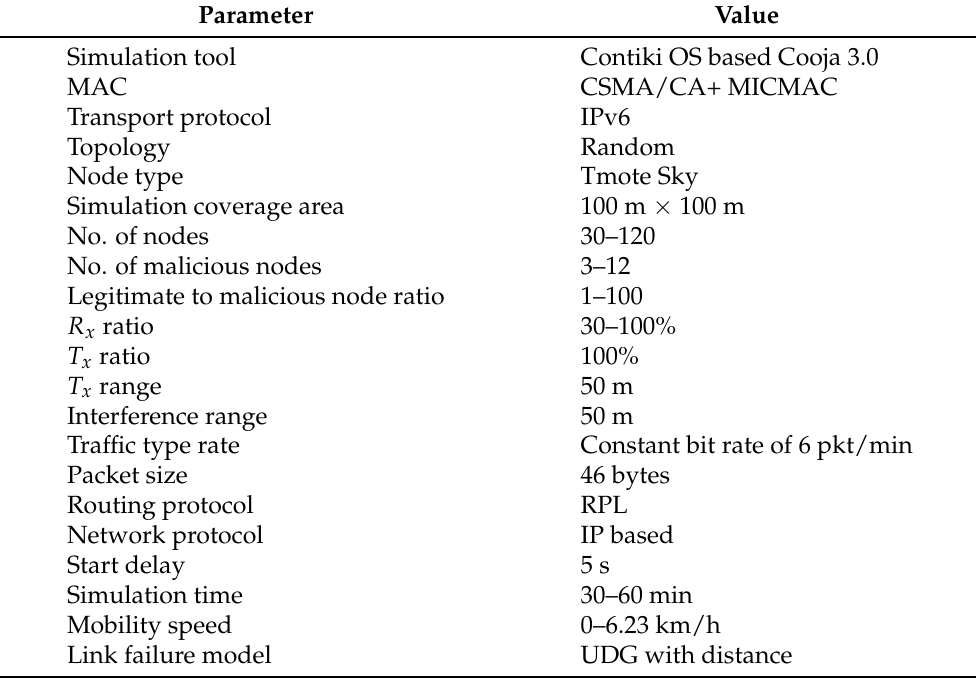
Table 2. Simulation parameters.